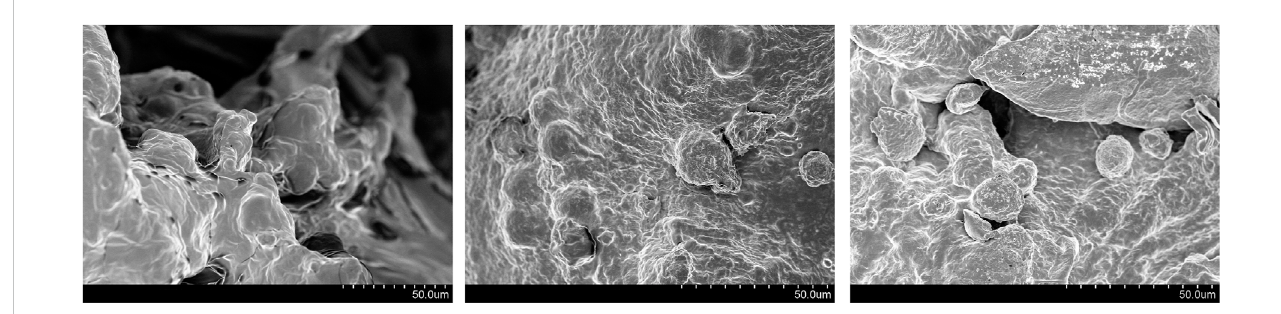
FIGURE 7 Electron microscope picture of the adhesion and growth of L929 cells on